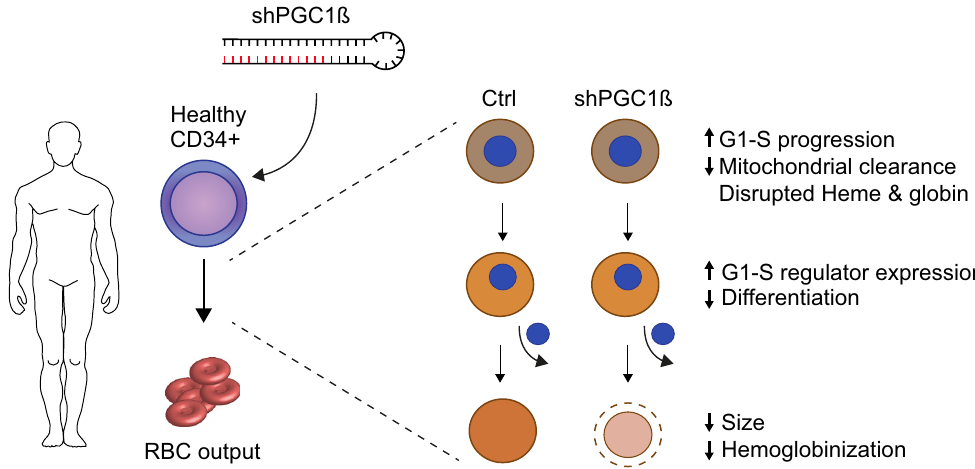
Figure 6. PGC1β is directly involved in mitochondrial clearance, production of hemoglobin and regulation of G1-S transition and is ultimately required for proper terminal erythroid